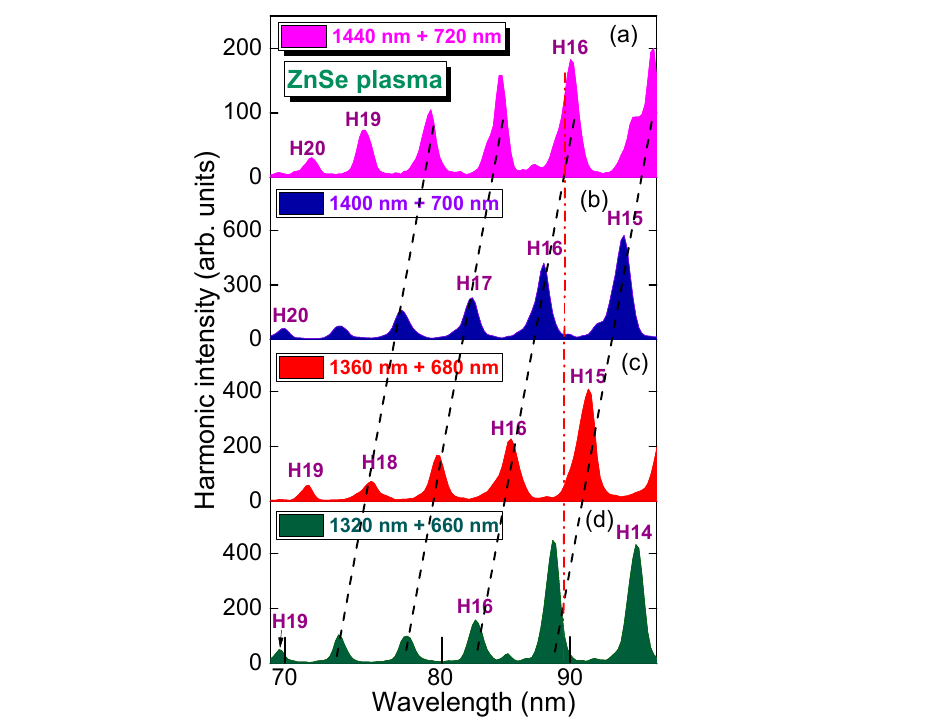
Figure 4. Harmonics generation in ZnSe plasma using the tunable NIR pulses. The wavelength of driving pulses was gradually tuned between 1320 and 1440 nm. No enhancement of odd and even harmonics in the vicinity of 89.3 nm was observed. Inclined dashed lines show the tuning ranges of odd and even harmonics. H14–H20 correspond to the harmonic orders. Dash-dotted line shows the position of the 3d 10 4s–3d 9 4s4p transition. The two-color pump schemes were used during these studies with the following wavelengths of the interacting pulses: ( a ) 1440 nm and 720 nm, ( b ) 1400 nm and 700 nm, ( c ) 1360 nm and 680 nm, and ( d ) 1320 nm and 660 nm.